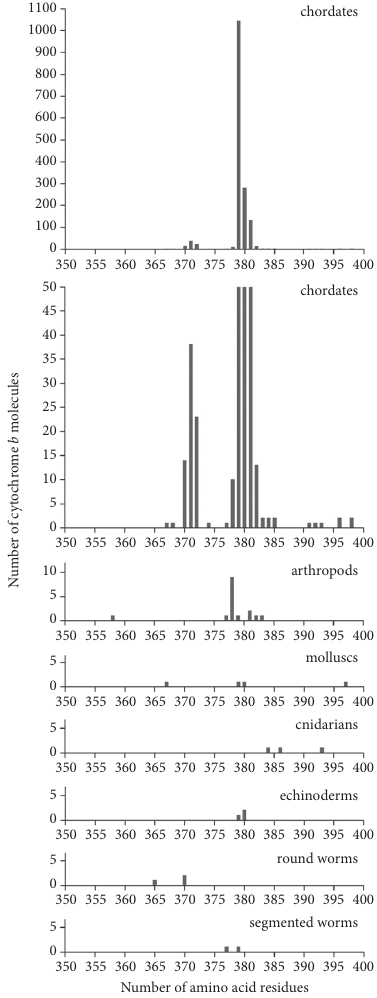
Figure 4: Distribution of the number of cytochrome b molecules, according to data from the Swiss-Prot database on the number of amino acid residues in various biological phyla. The data for chordates are presented at two scales of the ordinate—a truncated one, revealing small peaks throughout the entire region where lengths of amino acid residues exist, and a full one, where the entire maximum peak of the distribution is visible. Table 4: Content of the number of cytochrome b amino acid sequences in the Swiss-Prot database in various taxonomic groups a of chordate ( Chordata )